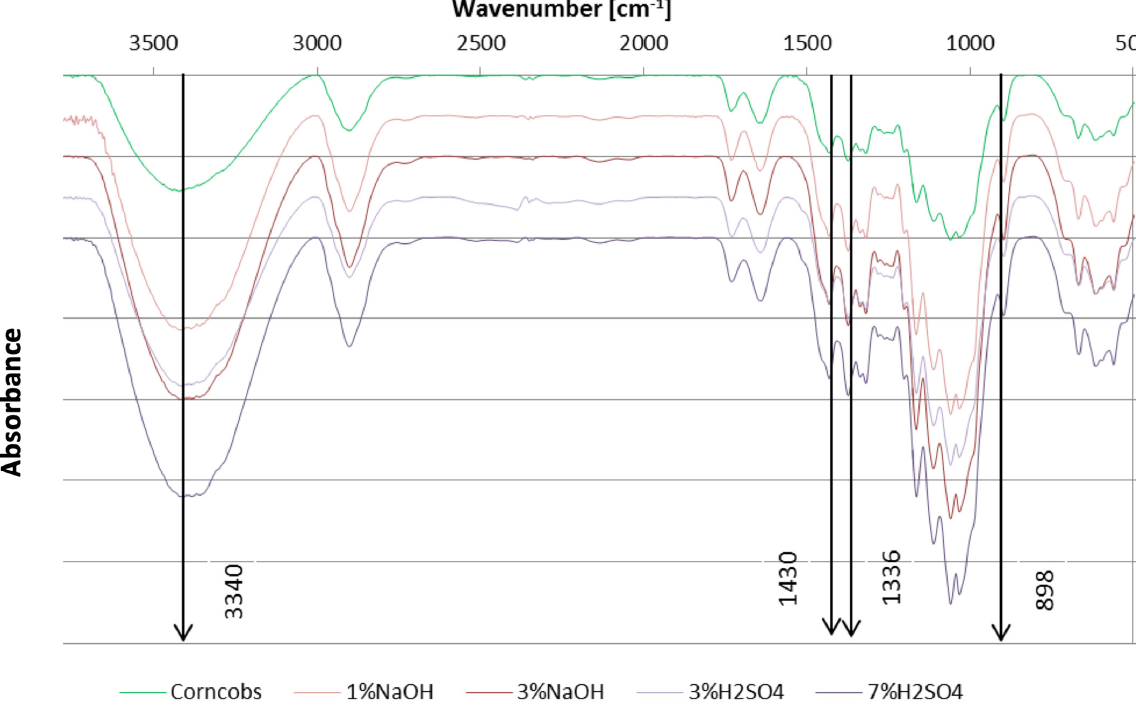
Figure 3. FTIR spectrum of corncob cellulose before and after pretreatment.